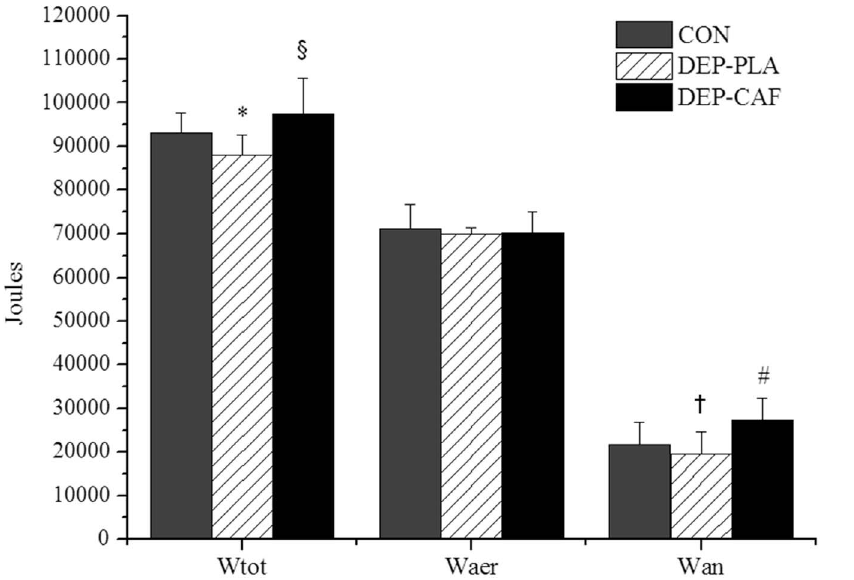
Figure 3. Mean and SD for work total (Wtot), total aerobic (Waer) and anaerobic work (Wan) during the 4-km cycling TT for control (CON), low carbohydrate availability with placebo ingestion (DEP-PLA) and low carbohydrate availability with caffeine ingestion (DEP-CAF). *Moderate effect of DEP-PLA compared to CON (ES=0.93). 1 Small and moderate effect of DEP-CAF compared to CON and DEP-PLA (ES=0.53 and 1.18, respectively). { Small effect of DEP-PLA compared to CON (ES=0.40). # Moderate and large effects of DEP-CAF compared to CON and DEP-PLA (ES=0.96 and 1.33, respectively).